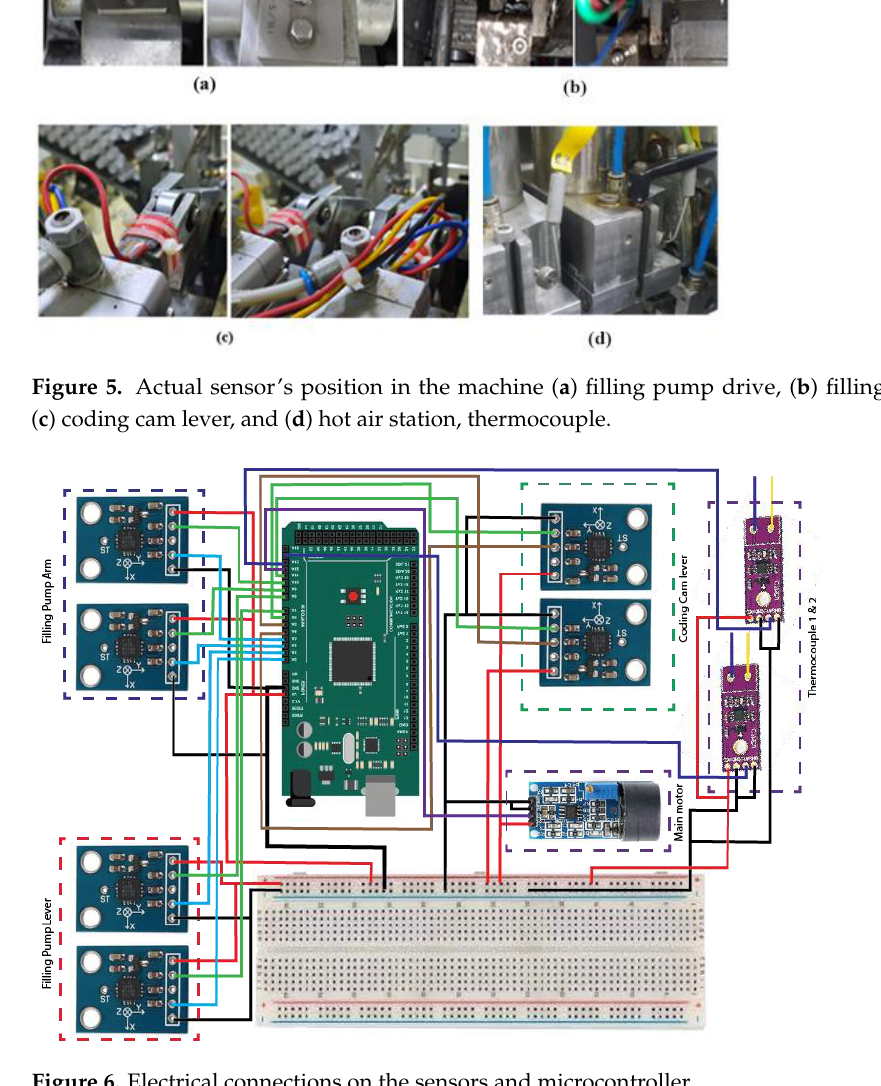
Figure 6. Electrical connections on the sensors and microcontroller.